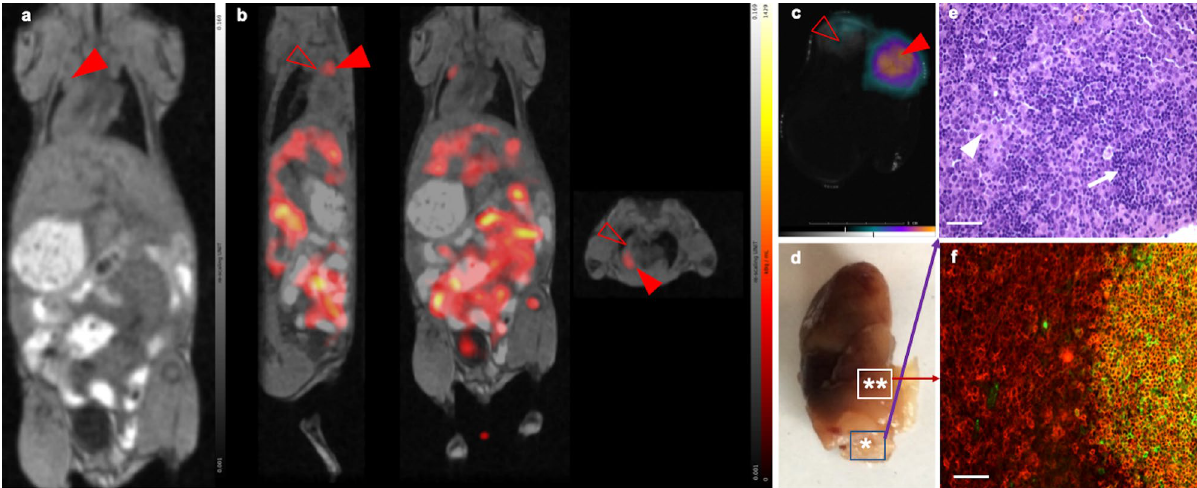
Figure 2. End-stage lymphoma-bearing mouse images show specific accumulation of 67 Ga-citrate in parathymic lymph nodes. ( a ) MRI: enlarged mediastinal lymph node conglomerate with signs of tumor infiltration (red arrowhead). ( b ) 67 Ga-citrate SPECT/MRI: SPECT/MRI assessment shows tracer accumulation in a part of the left parathymic lymph node (from left to right in this panel, sagittal, horizontal and axial plane view, focused on the parathymic region). The red full arrowhead shows the tracer accumulating part of the infiltrated lymph node, while the empty arrowhead points to the part of the enlarged lymph node not accumulating 67 Ga-citrate. ( c ) Ex-vivo Cerenkov image shows 67 Ga-citrate accumulation in the previously identified part of the parathymic lymph node and low accumulation in the part identified with the empty arrowhead in SPECT/MRI. Scale bar corresponds to 1 cm. ( d ) Stereomicroscopic image of the same parathymic lymph node. Two areas are identified, * in the lower rectangle shows the tumor-infiltrated part, its histology analysis image indicated by a purple arrow, ** in the upper rectangle identifies the tumor infiltration border area in the lymph node. The corresponding immunohistochemistry image in ( f ) is pointed at with a red arrow. ( e ) Haematoxylin–eosin staining microscopy image of a section from the infiltrated part of the parathymic lymph node, identified with ( a ) * in ( d ). The sample is taken from the area in the lower rectangle of the stereomicroscopic image shown with *. Small clusters of residual normal lymphocytes (arrow) are visible,